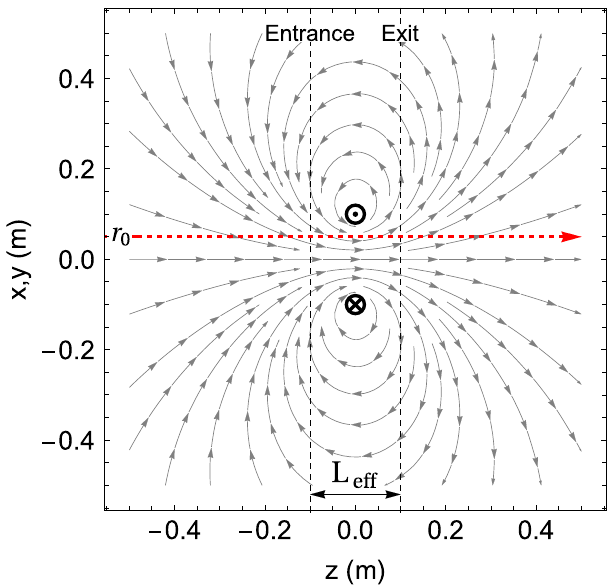
2. Simulation of proton dynamics in 3D field of the current loop with radius R ¼ 0 . 1 m. The gray arrows show precise magnetic field distribution of the current loop. The proton starts with f x; 0 ; y; 0 g parameters where r 0 ¼